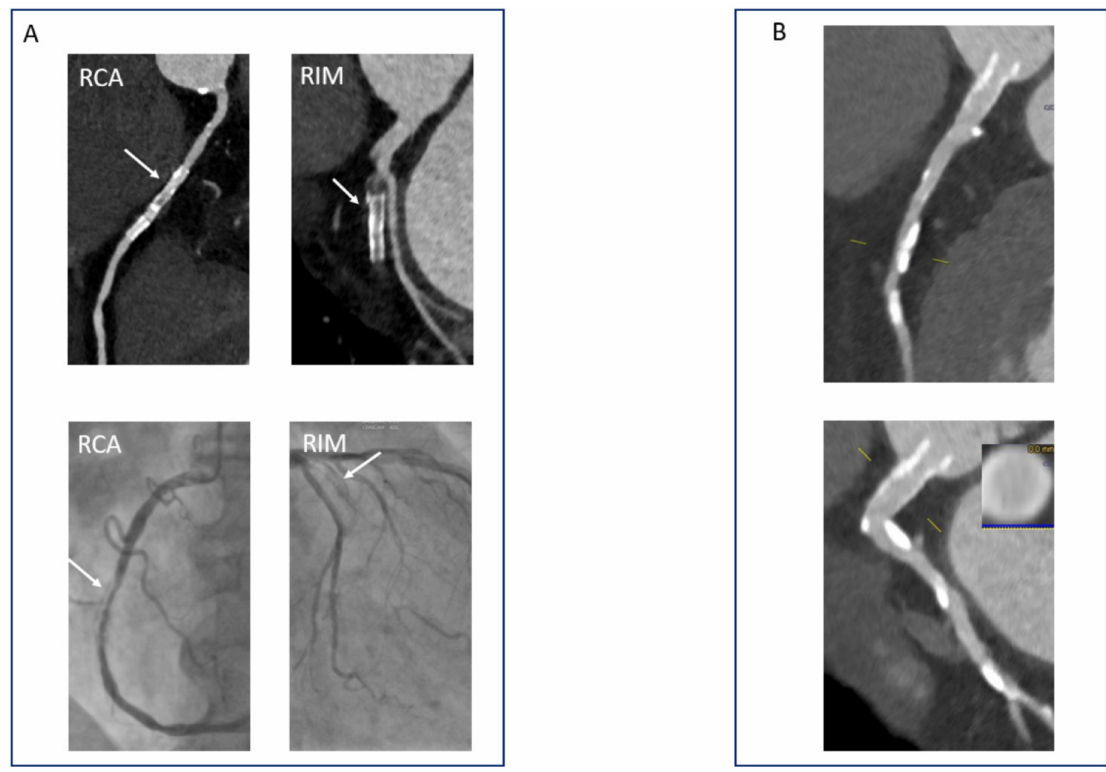
Figure 10. CCTA in the evaluation of coronary stents. ( A ) Note the in-stent restenosis in the RCA as well as the stent occlusion in the ramus intermedius in a patient with coronary stent placement 8 years ago (ICA images for comparison). ( B ) CCTA evaluation of a stent placed in the left main 3 years after the